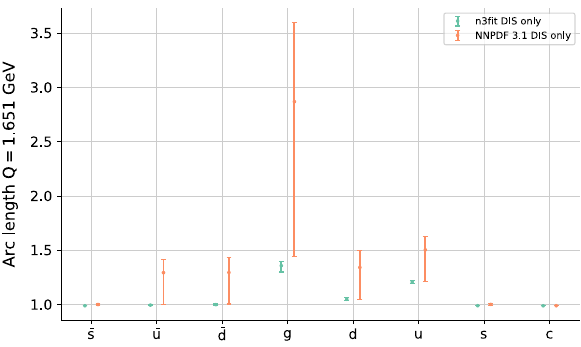
Fig. 7 Comparison for the DIS only setup of the arc-lengths between the new and old methodologies. The new methodology produces smoothercurveswhichtranslatestosmallerandmorestablearc-lengths